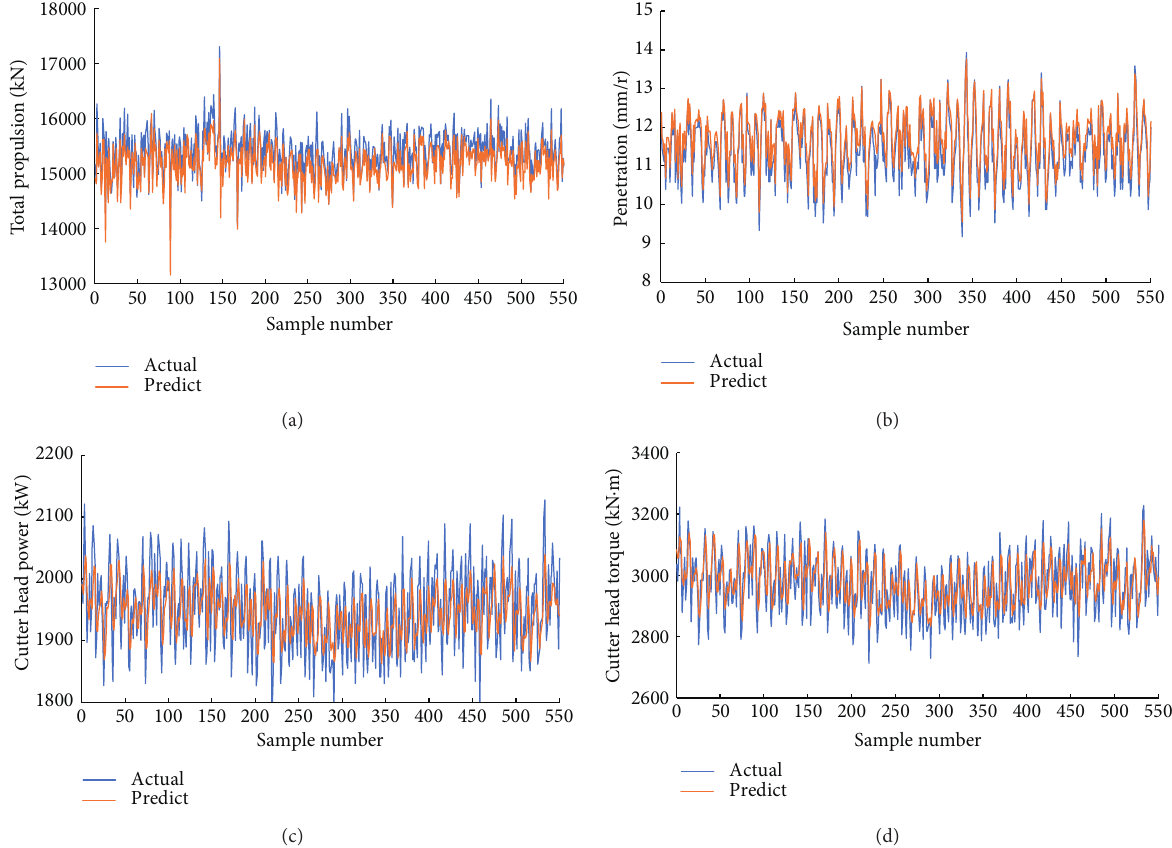
Figure 13: Prediction results of LSTM model. (a) Prediction results of total thrust F . (b) Prediction results of penetration e . (c) Prediction results of cutterhead power P . (d) Prediction results of cutterhead torque T